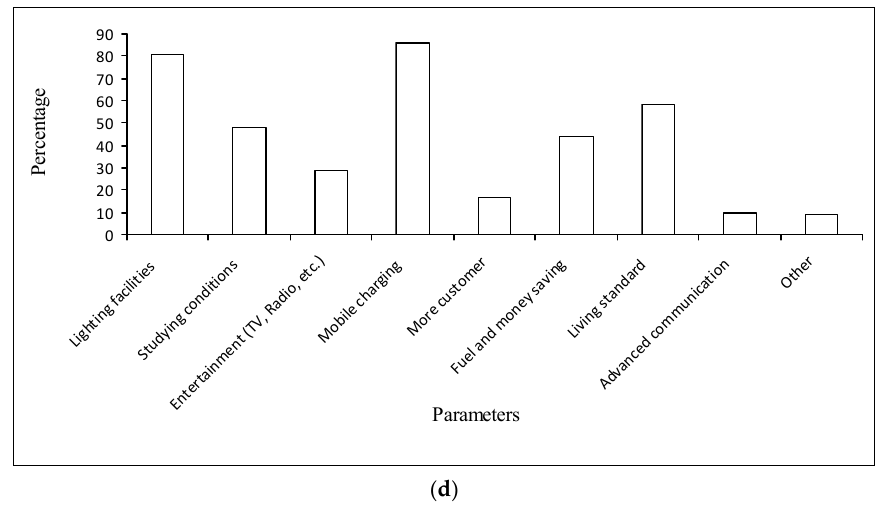
Figure 5. ( a ) Occupation of the responders; ( b ) Household income per month in BDT; ( c ) Load use data by households; ( d ) Impacts of SHS on improving the quality of life.